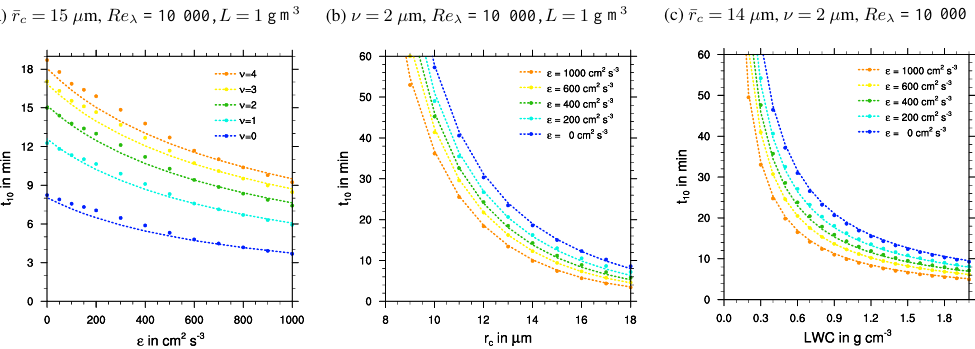
Figure 3. Time t 10 that is needed to convert 10% of the initial cloud water to rainwater: (a) t 10 as a function of dissipation rate (cid:15) for various ν (and ¯ r c = 15µm, Re λ = 10000), (b) t 10 as a function of mean cloud droplet radius ¯ r c for various values of dissipation rate (cid:15) (and ν = 2, Re λ = 10000), and (c) t 10 as a function of the initial cloud liquid water content for various values of dissipation rate (cid:15) (and ¯ r c = 14, ν = 2, Re λ = 10000). Data points are numerical solution of the SCE; dashed lines represent the solutions of the two-moment bulk scheme with the enhancement factor for autoconversion based on the Onishi kernel as given by Eq. (10) and the coefficients of Table